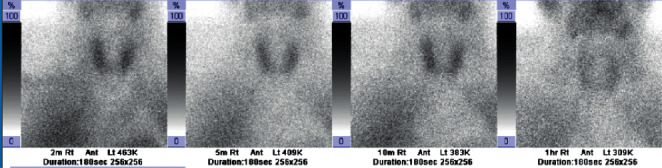

99m-STS with a dose of 24.9 mCi demonstrating persistent activity in the right and left lobes of the slightly enlarged thyroid gland at 10 minutes, declining at 60 minutes' image confirming diagnosis of AIT-1.